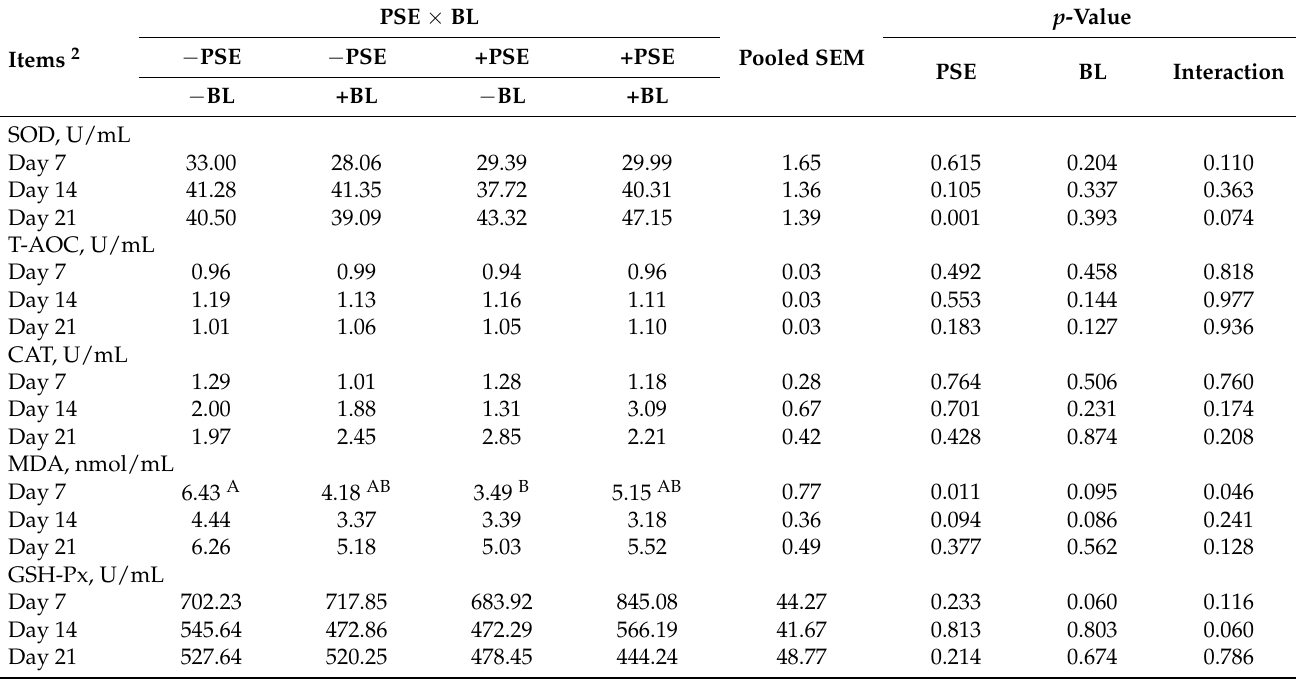
Table 7. Effects of BL and PSE on serum antioxidant indices of weaned piglets 1 . PSE × BL